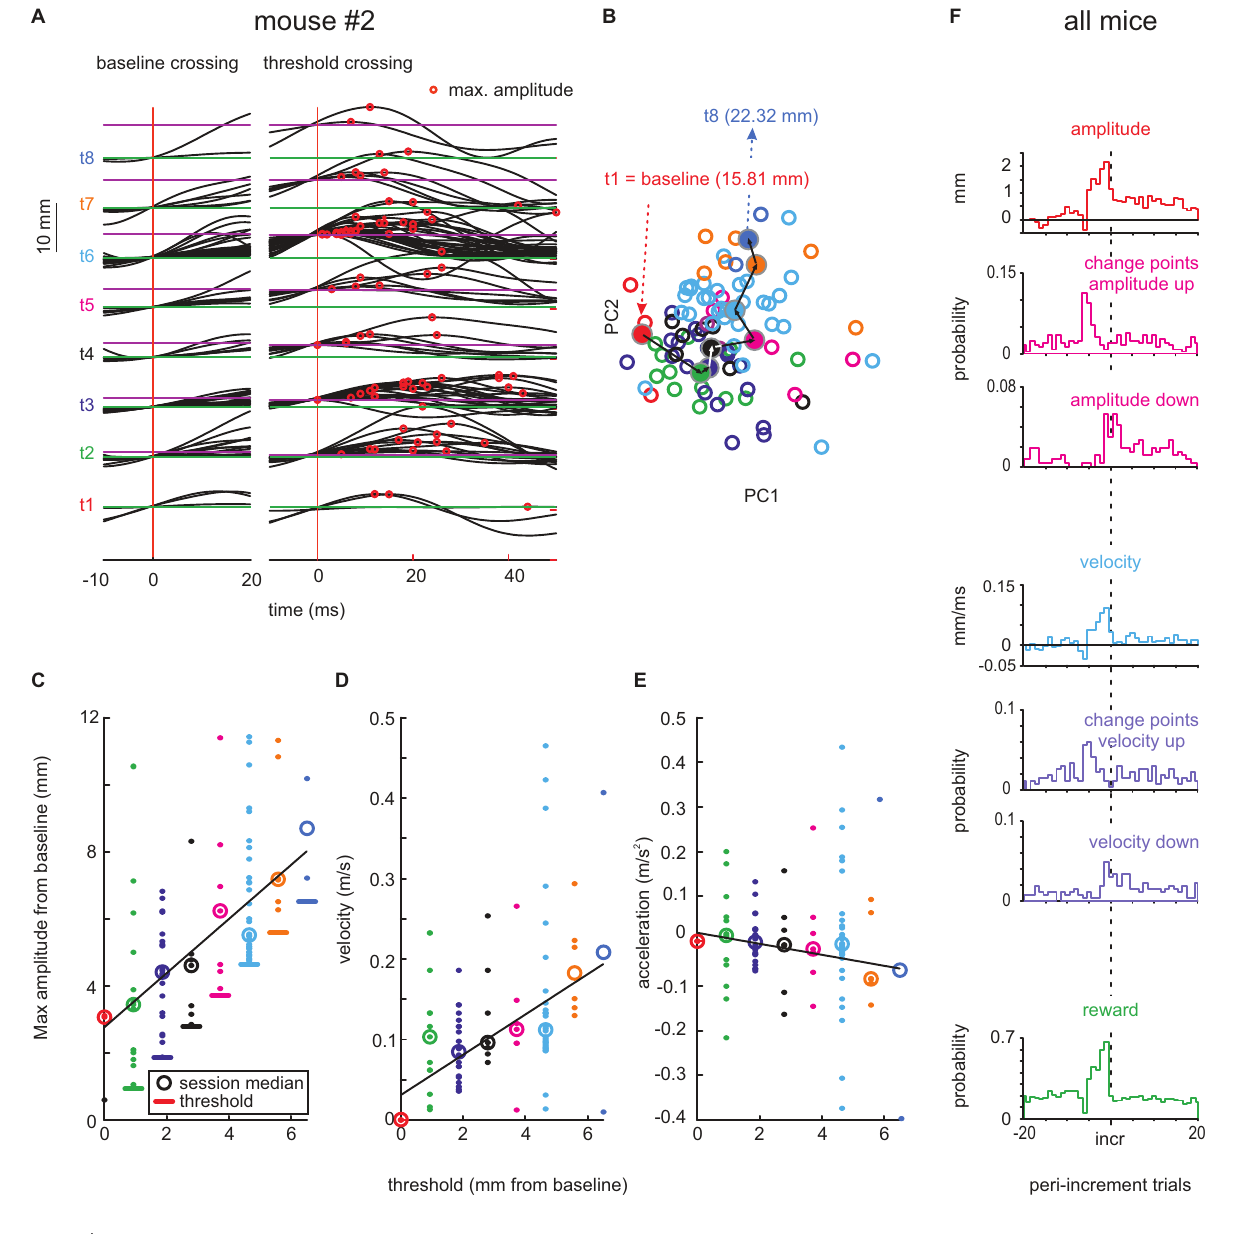
FIGURE 4 | Adaptive whisking up to 12 days after contralateral RW lesion. (A–E) Example session. (F) Population data. Same conventions as in Figure 2